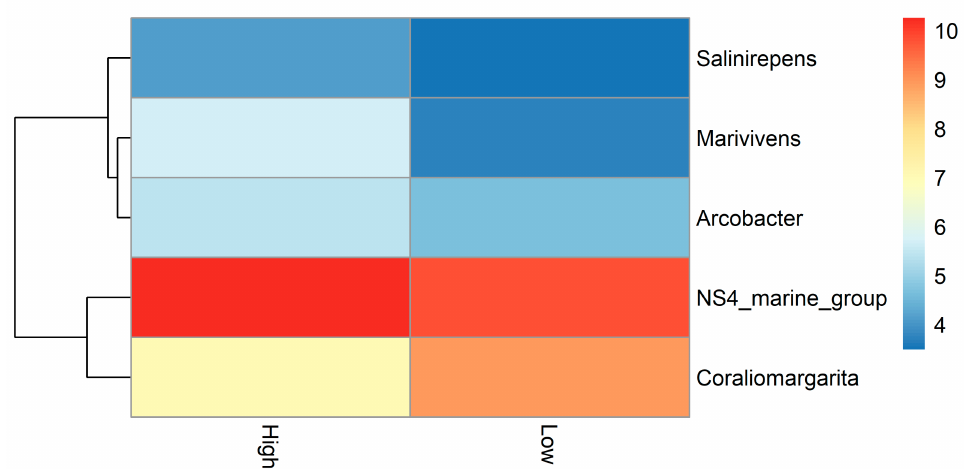
Figure 5. Heatmap clustered by rows showing the DESeq2 normalized abundance of the bacterial gener with a significant relationship with the high and low abundance of C. irritans (eDNA- based on mean values of C. irritans 18S SSU-rDNA gene copies/uL using digital droplet PCR quantification) from marine fish sea cages from Hong